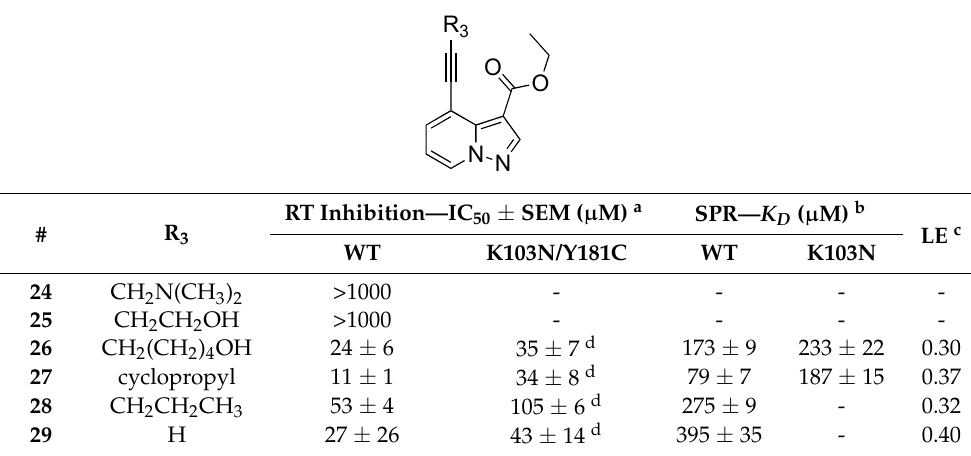
Table 2. HIV-1 RT inhibition, dissociation constants and ligand efficiencies of substituted 4-alkyne pyrazolopyridine analogues (Series 3).